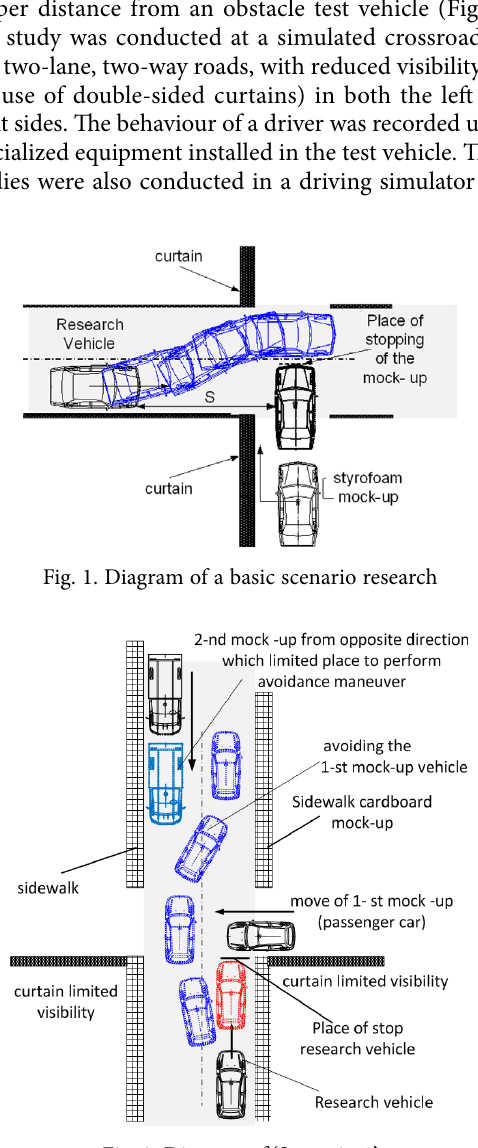
Fig. 2. Diagram of ‘Scenario 1’